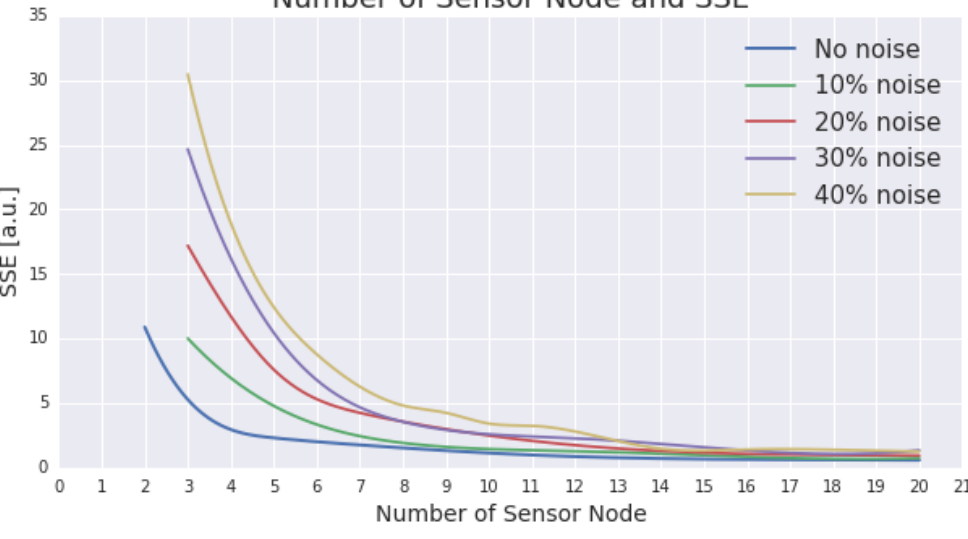
ESN design (sensor nodes placement). The noise are set within the range of 10%, 20%, 30%, and 40% (illustrated by green, red, purple, and yellow lines, respectively). For comparison purposes, the performance of the ESN design without noise is also presented (using blue